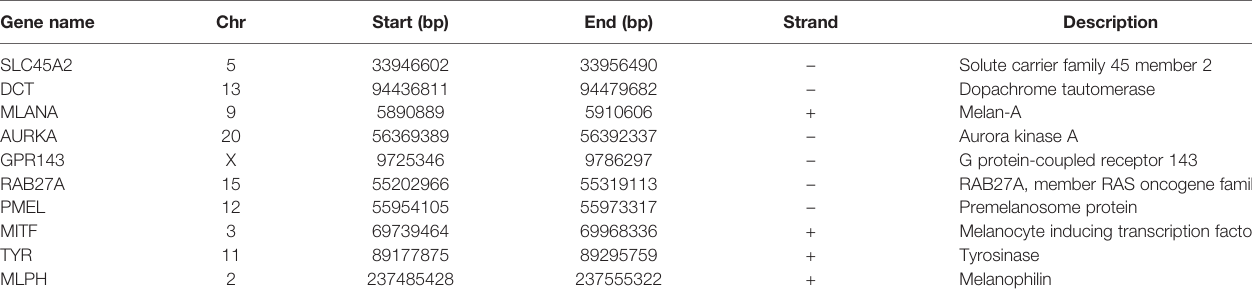
TABLE 1 | Information of hub genes related to SKCM identi fi ed by WGCNA.